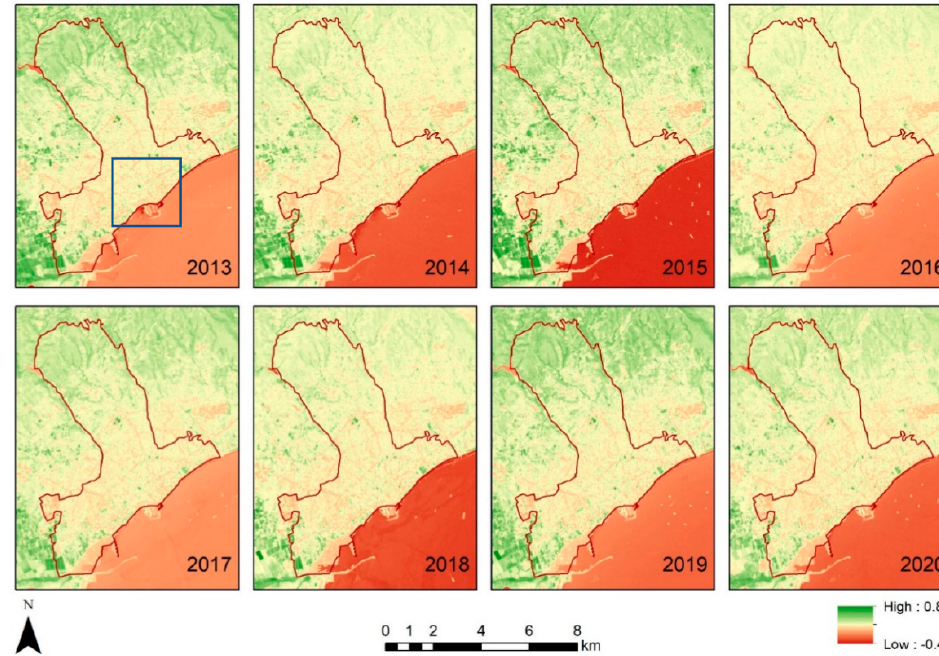
Figure 7. NDVI maps for Limassol case study (b) (Limassol) per year. For the specific areas within the red rectangle, some changes are noted between the years 2017 and 2020 in the Strovolos case study (Figure 8, top, red rectangle), while in the Limassol area, no significant changes are recorded (Figure 8, bottom, red rectangle). These changes could be a result of a land-use change or seasonal changes.